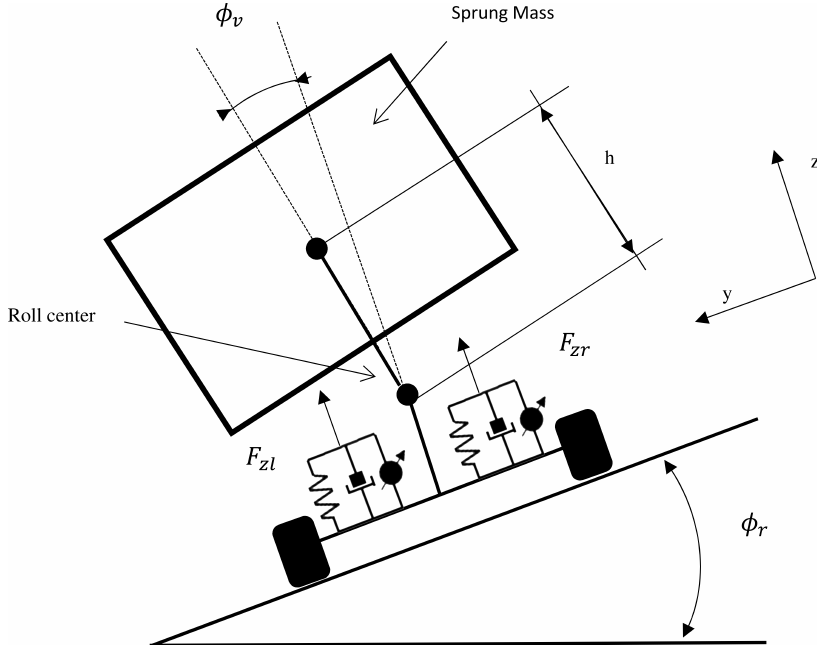
Figure 1. Flat roll model.